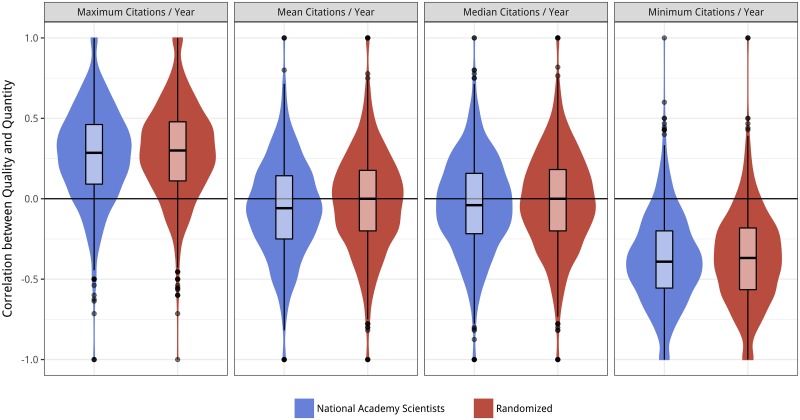
Violin plots of the strength of pairwise correlation between quantity and quality for members of the National Academy of Sciences.The panels are divided based on which summary statistic is being compared across years (e.g. maximally-cited paper published in that year). A value of 1 (-1) indicates that, for every pair of adjacent years, the more productive one had a higher (lower) statistic. A value of 0 (horizontal black line) indicates that the larger statistic is equally likely to be from the more or less productive year. In blue (left in each plot) are the empirically observed correlation values for each author. In red (right in each plot) are the correlation values observed when citation counts were randomized within each author’s corpus.